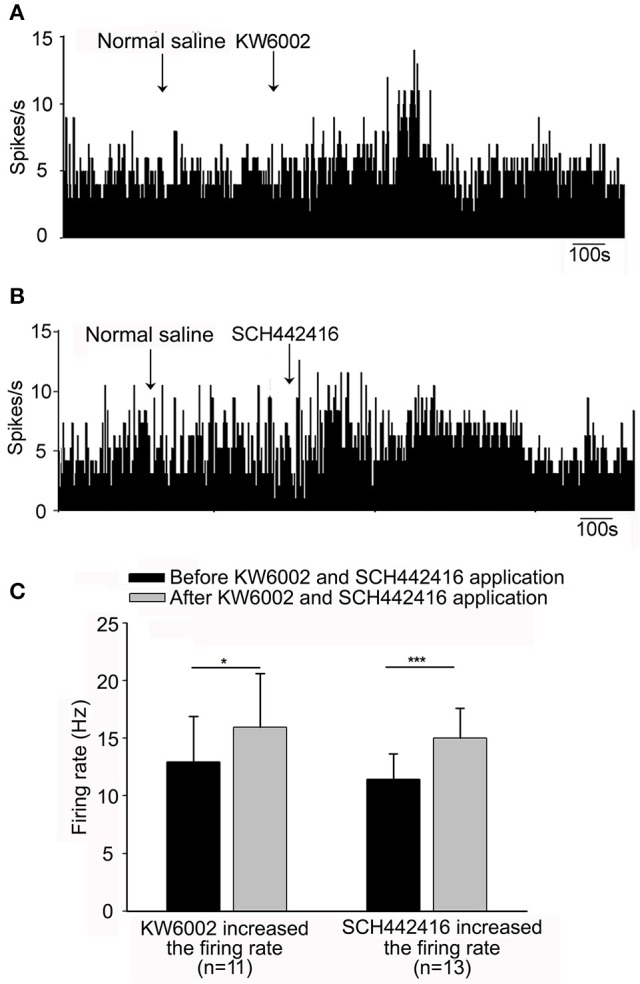
Effects of adenosine A2A receptor antagonists, KW6002 and SCH442416, on the spontaneous firing of pallidal neurons in normal rats. (A) Typical frequency histograms showing that 1 μM KW6002 increased the firing rate of a pallidal neuron. (B) In this neuron, 1 μM SCH442416 increased the firing rate. (C) Pooled data summarizing the excitatory effects of both KW6002 and SCH442416 on the firing rate of pallidal neurons. The black bars represent the basal firing rate before drugs application, while the gray bars represent the firing rate after drugs application. *P < 0.05, ***P < 0.001, paired-samples t-test.